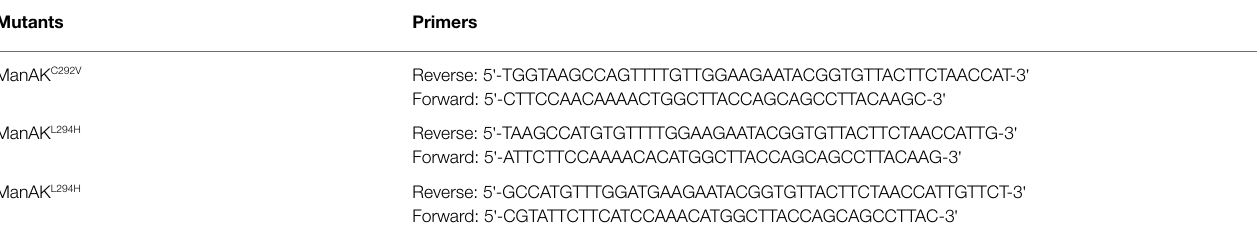
TABLE 1 | Primers used for site-directed mutagenesis. Mutants